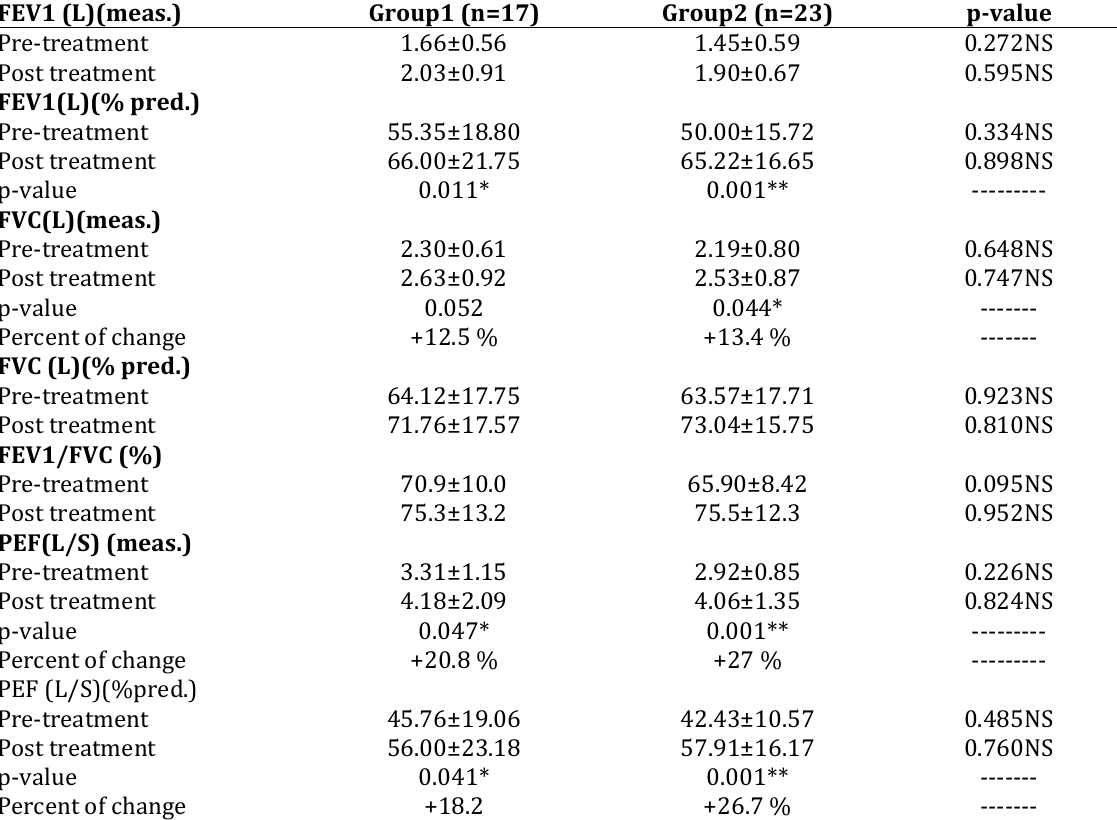
Table II. Effect of conventional therapy alone and in combination with curcumin supplement on PFT after two months.